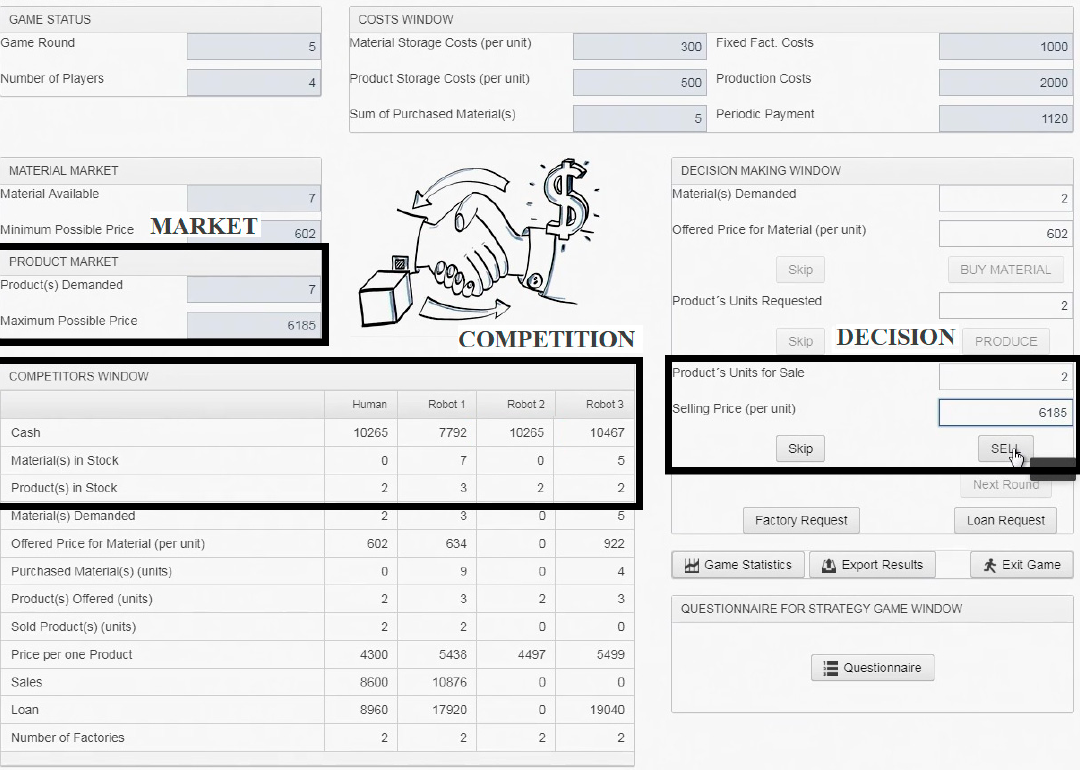
Figure 1. The game window of FactOrEasy ® with the areas of interest (AOIs), that contain figures necessary for the decision in the selling phase.